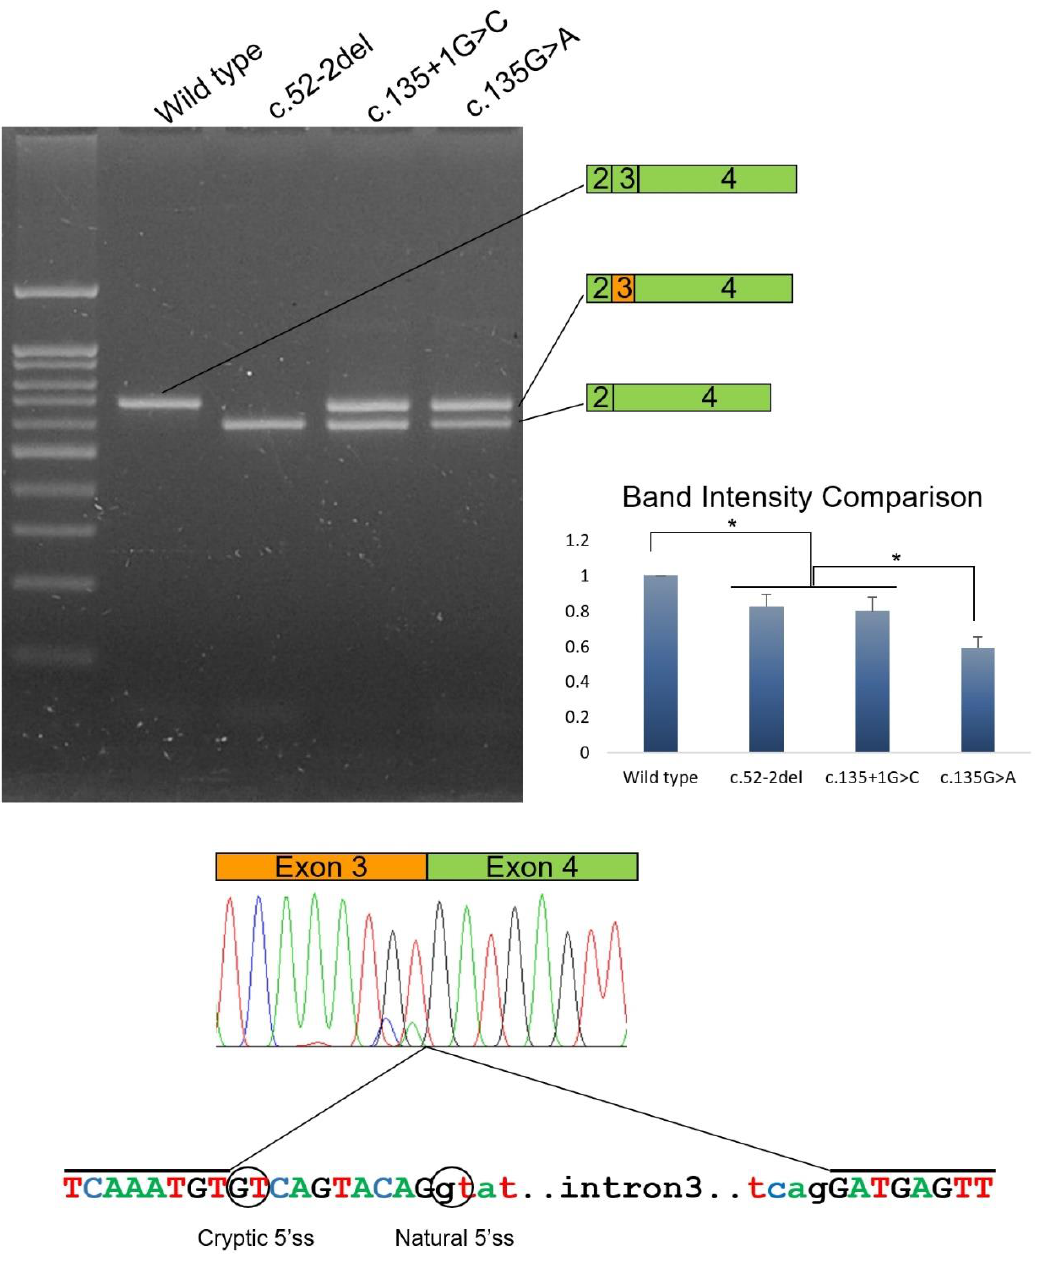
Figure 4. Agarose gel image of the splicing assay of the wild-type and mutants. Left lane is the DNA ladder. Wild-type and mutant names are shown above the gel image. Wild-type sequence resulted in normal splicing products including exons 2, 3, and 4. Deletion mutation (c.52-2del) resulted in an exon 3 deletion. Mutations c.135+1G>C and c.135G>A resulted in two bands: alternative splicing band using a cryptic 5 ′ splicing site (a shorter exon 3 with orange color) and an exon 3 deletion band. Band intensity comparison shows that the exon 3 deletion band intensity of the c.135G>A mutation is significantly weaker than the other two mutants (asterisk indicates p < 0.01). Intensity of the wild type band was stronger than the exon 3 deletion band of all the mutants (asterisk indicates p < 0.01). Sequencing chromatograms of the alternative splicing band are shown below. Abnormal, shorter exon 3 sequences are indicated with an orange box above the chromatogram. Cryptic and natural 5 ′ splicing sites are indicated with black circles. The sequences included in the chromatogram are indicated with black lines above the sequences.